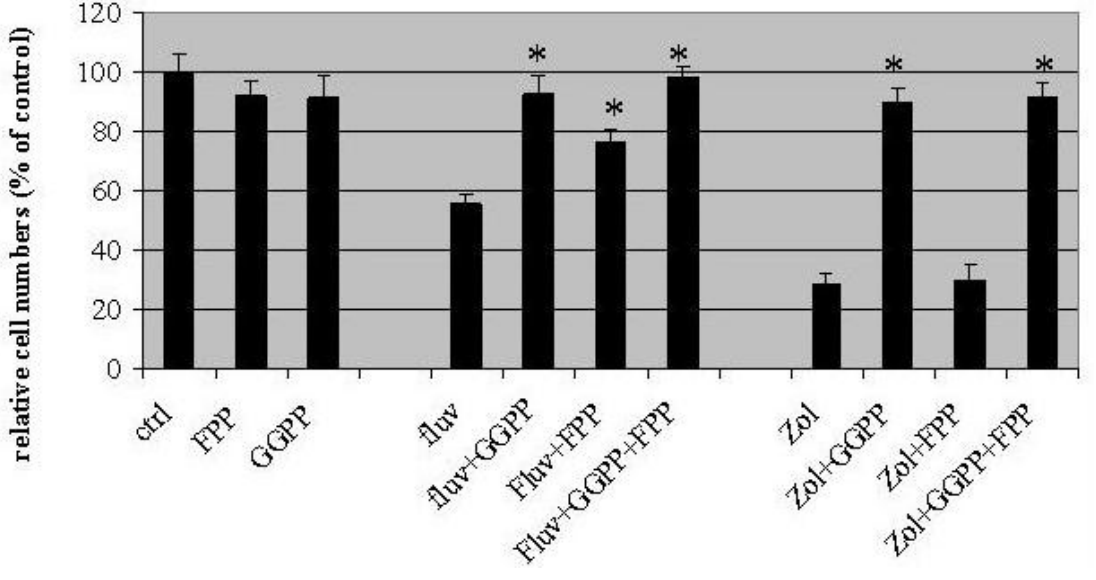
Figure 2. Reversal of cell growth inhibition induced by fluvastatin (Fluv) and zoledronic acid (Zol) with geranylgeranyl pyrophosphate (GGPP) and farnesyl pyrophosphate (FPP). Control cells were maintained in growth medium and represent 100% cell growth. GGPP significantly rescues cell death from both drugs (P < 0.01, n = 3), but FPP only blocks cell growth inhibition induced by fluvastatin (P < 0.01, n = 3). There is no significant difference between zoledronic acid alone and zoledronic acid + FPP (P = 0.388, n = 3). Data represent the mean ± SD from three separate experiments.